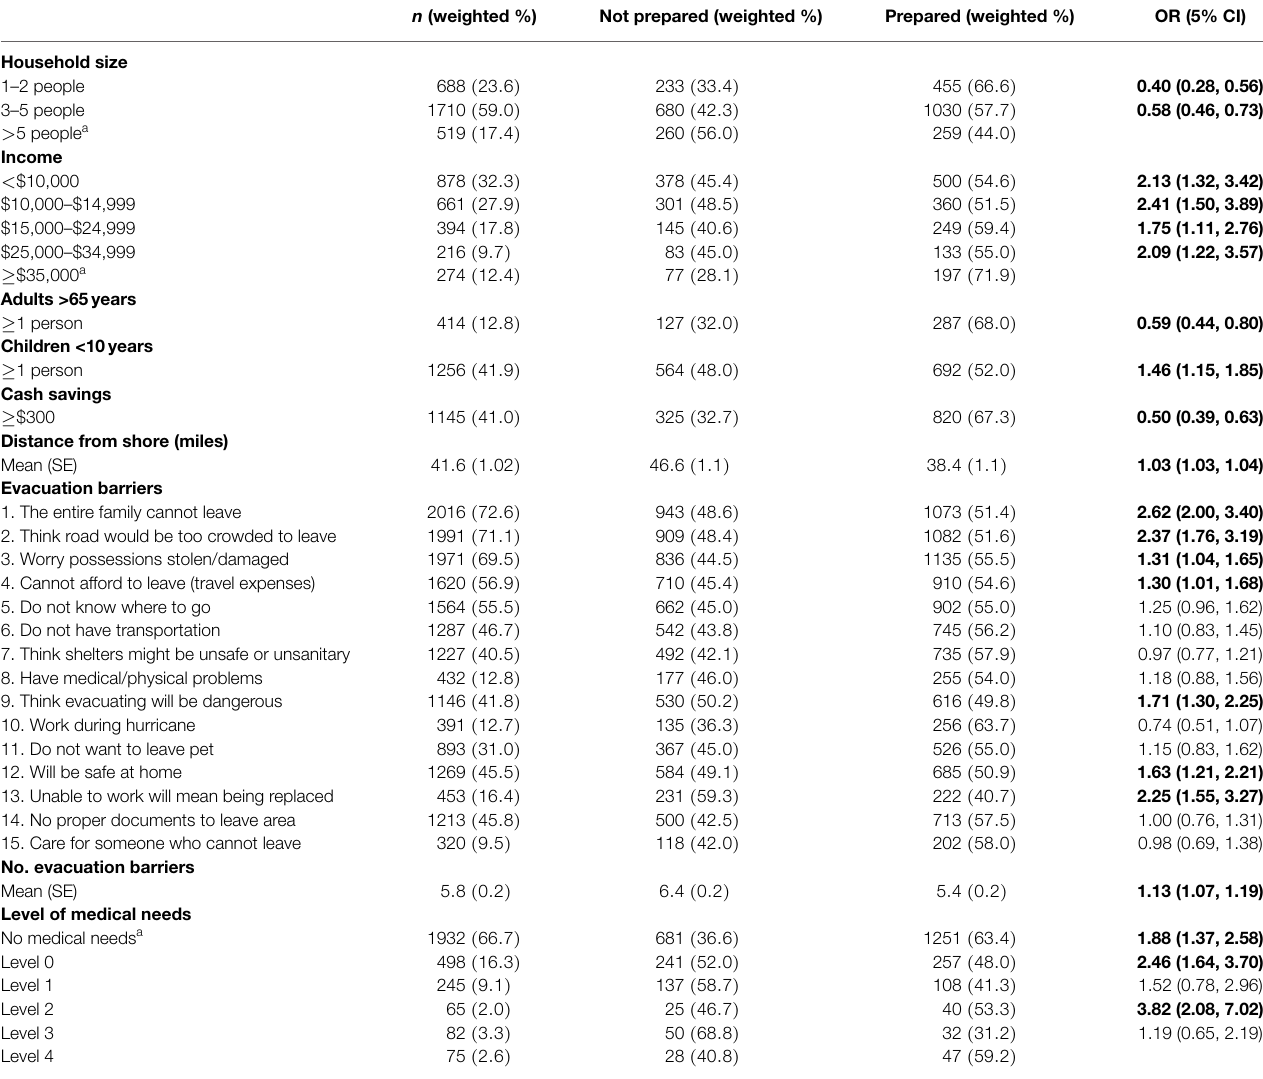
Bold font indicates statistical significance. SE, standard error. a Reference group. The percentages, odds ratios, and 96% confidence intervals are